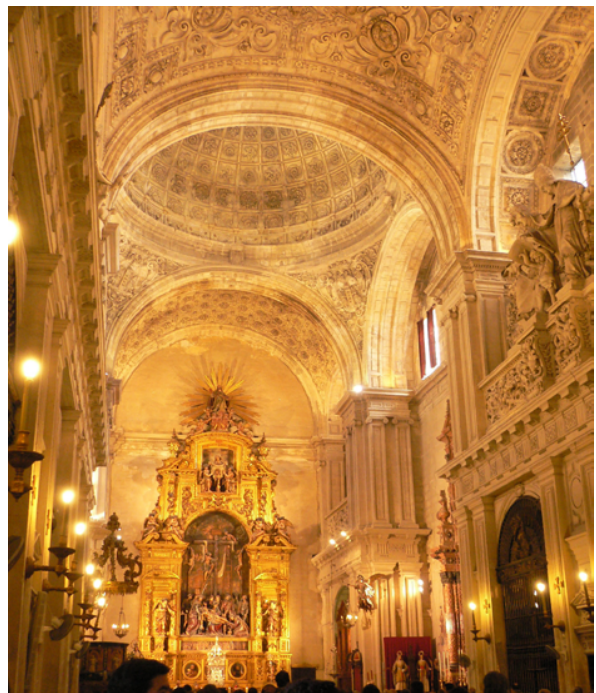
Figure 7: Interior of the Sagrario, looking from the entry towards the high altar. Photo by